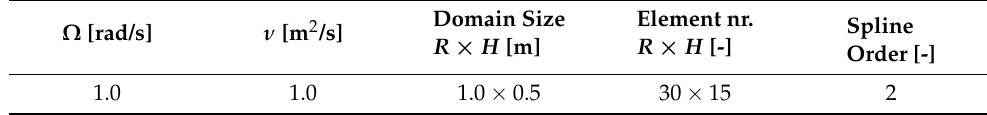
Table 1. Parameters used for the enclosed rotating disk